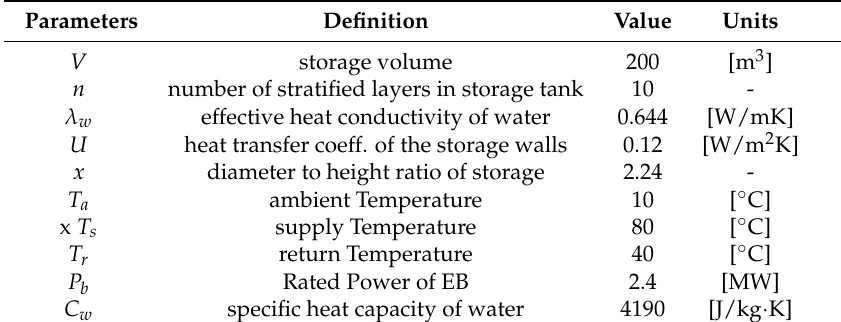
Table 2. Technical parameters of EB and storage.